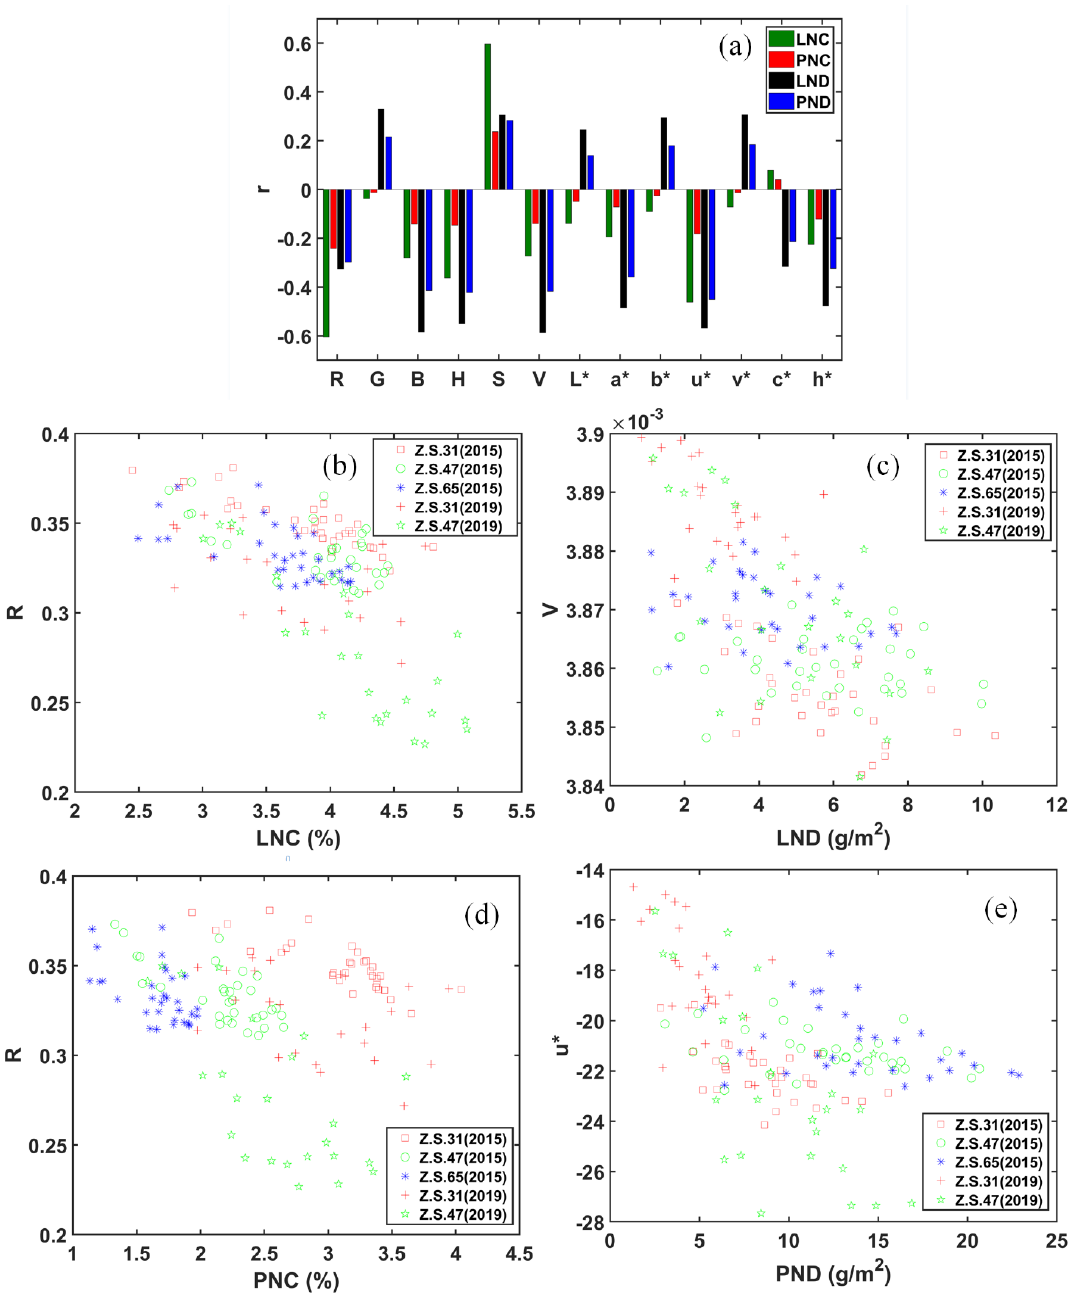
Figure 5. The responses of different color parameters to the four wheat N status indicators (i.e., LNC, PNC, LND, and PND) in the calibration dataset. ( a ) Pearson correlation analyses of color parameters and N status indicators, and ( b – e ) scatter plots of the best performing color parameters and N status indicators for each growth stage.